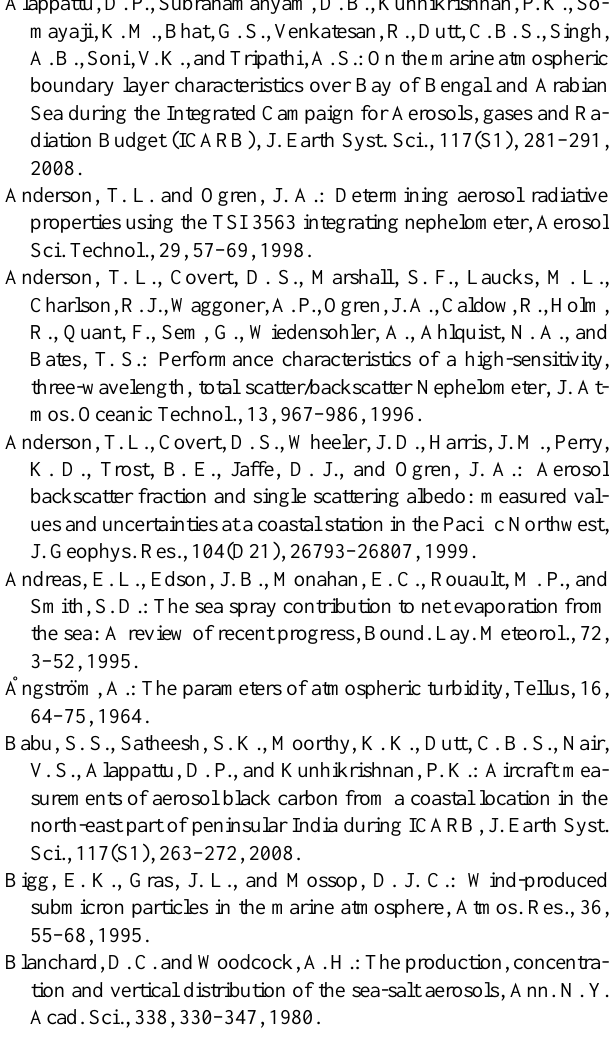
Fig. 17. Scatter plot of hemispheric backscatter ratio ( b ) against wavelength exponent ( α) . Solid line represents the linear regression fit between the two